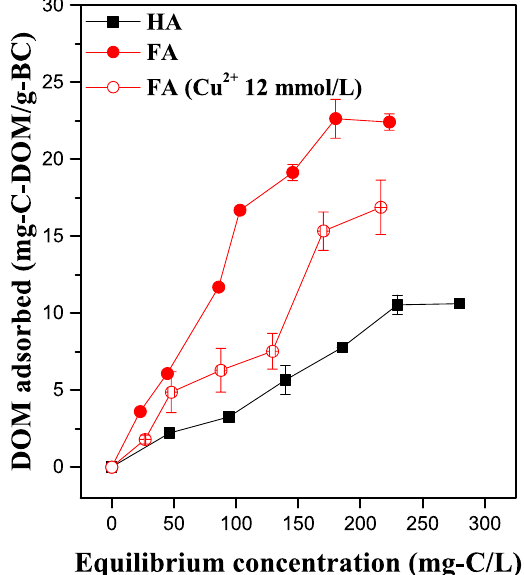
Figure 3. Adsorption isotherms of HA, FA, and FA in the presence of Cu 2 + on